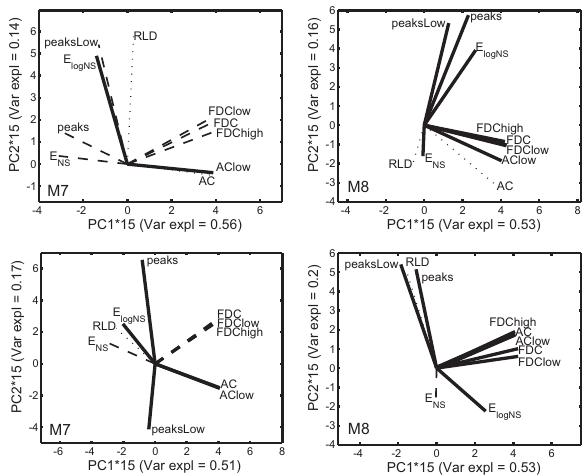
Fig. 12. PCA diagrams for M7 (left) and M8 (right) for both the Fig. 12: PCA diagrams for M7 (left) and M8 (right) for both calibration (top) and validation (bottom) period. The principal com- ponents are dimensionless. M8 shows a higher consistency for the the calibration (top) and validation (bottom) period. The calibration period and a more consistent behaviour between the cal- principal components are dimensionless. M8 shows a higher ibration and validation period. Presented results are for the Maimai consistency for the calibration period and a more consistent behaviour between the calibration and validation period. Pre- sented results are for the Maimai catchment.